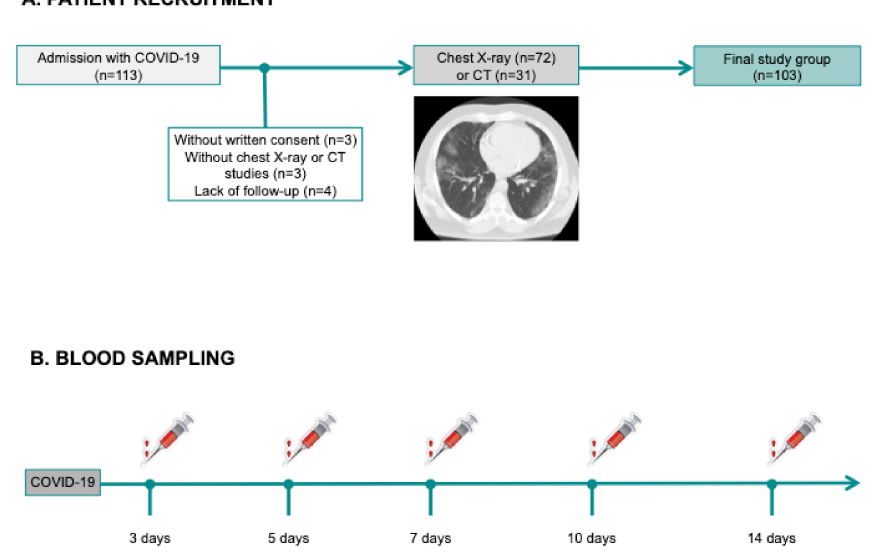
Figure 3. Flowchart of the COVID-19 study group, showing COVID-19 patient recruitment ( A ) and blood sampling ( B ). COVID-19: coronavirus disease 2019; CT: computed